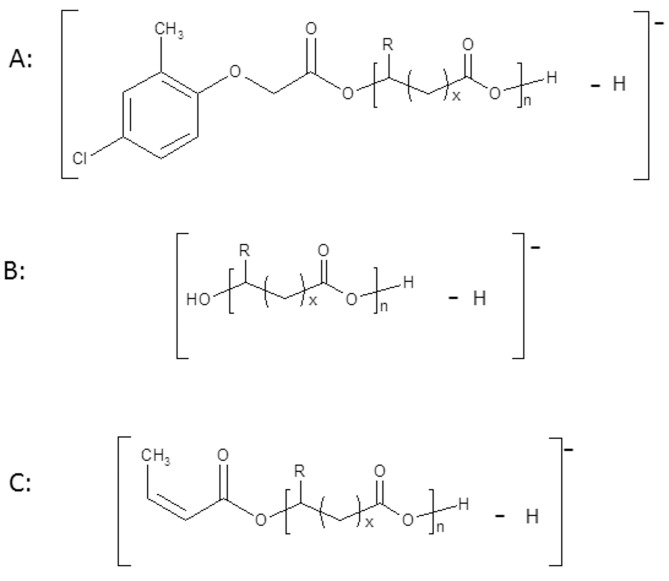
Structures of ions presented in the ESI-MS spectra in Fig. 9.